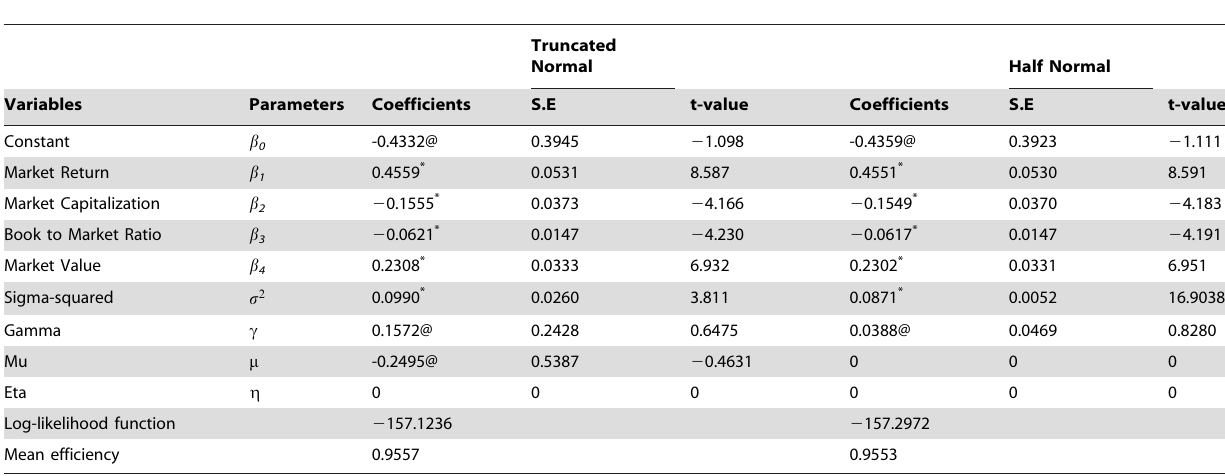
Table 3. Maximum-Likelihood Estimates of the Cobb-Douglas Stochastic Frontier Production Function with